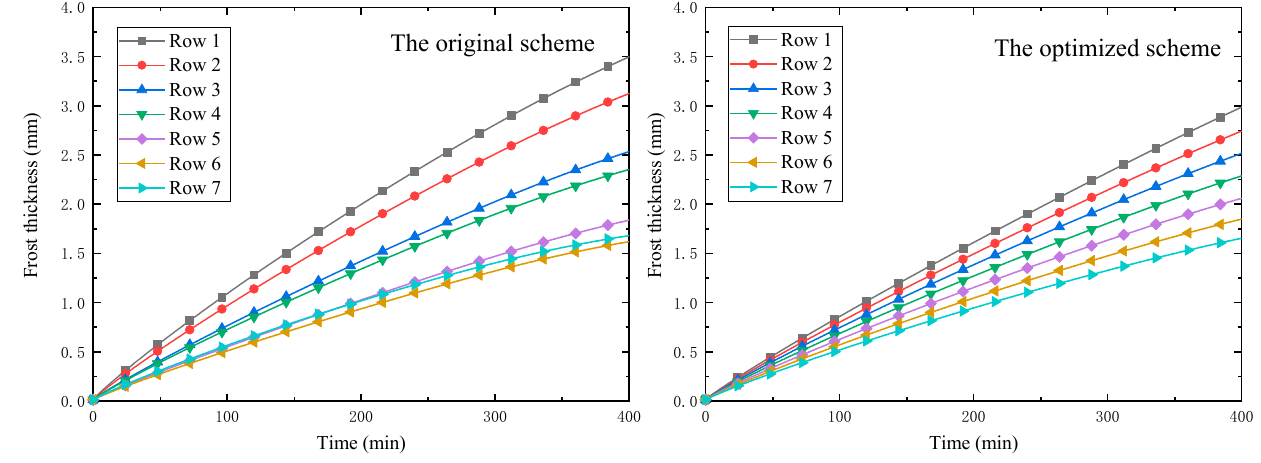
Figure 11. Frost thickness during 400 min duration.